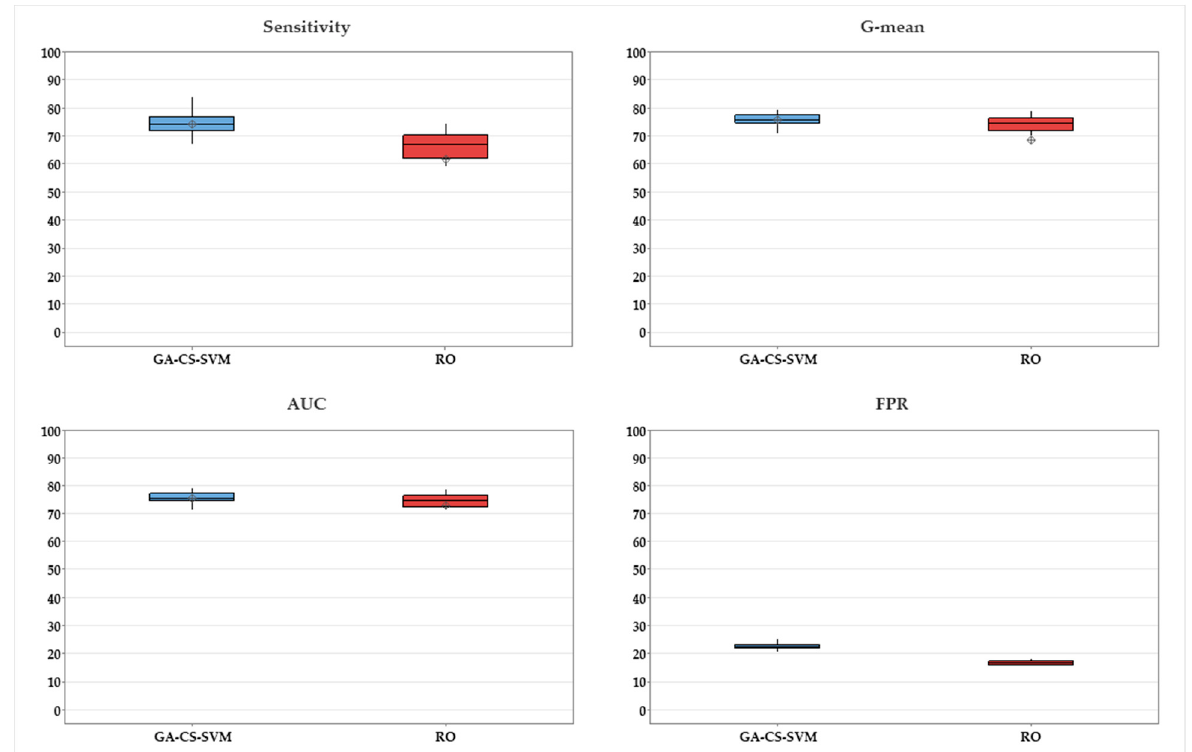
Figure 7. Comparison between GA-CS-SVM and balancing using RO.